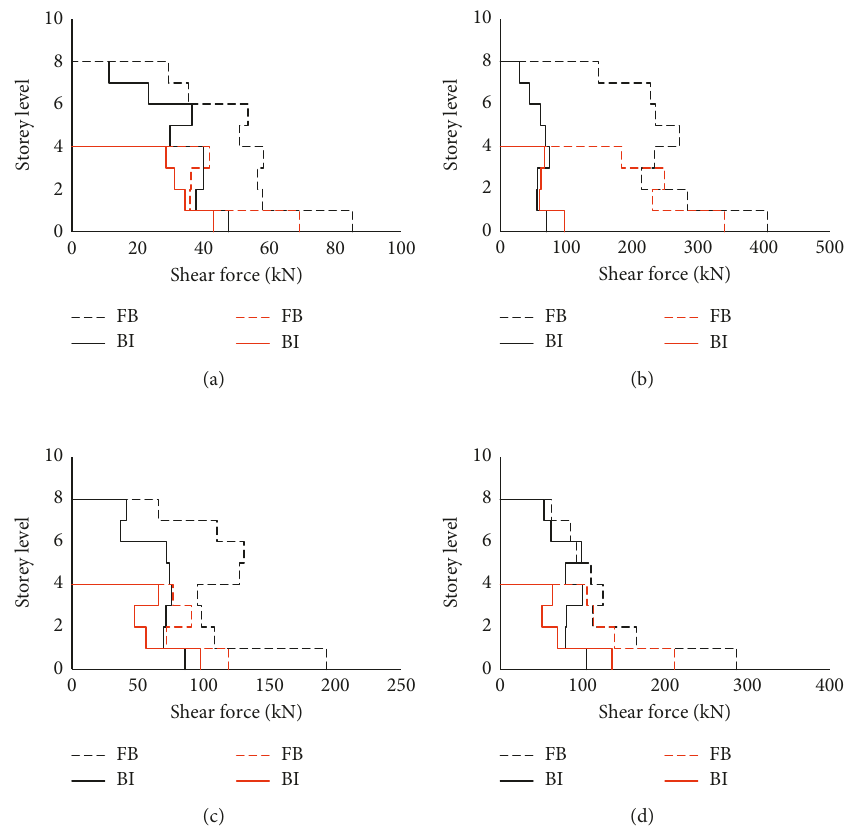
Figure 18: Storey shear force in the adjacent buildings subjected to the different ground motions.